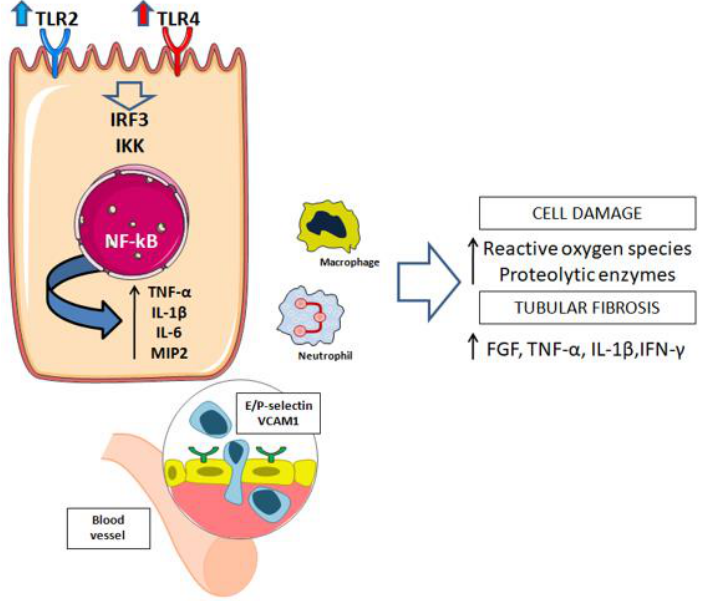
Figure 1. Renal tubular epithelial cell during ischemia.